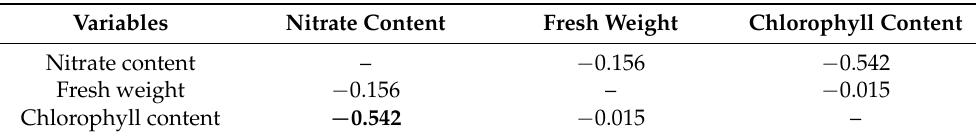
Table 1. Correlation matrix (Pearson) between variables in normal treatment. Variables Nitrate Content Fresh Weight Chlorophyll Content Nitrate content – − 0.156 − 0.542 Fresh weight − 0.156 – − 0.015 Chlorophyll content − 0.542 − 0.015 – Values in bold are different from 0 with a significance level alpha =